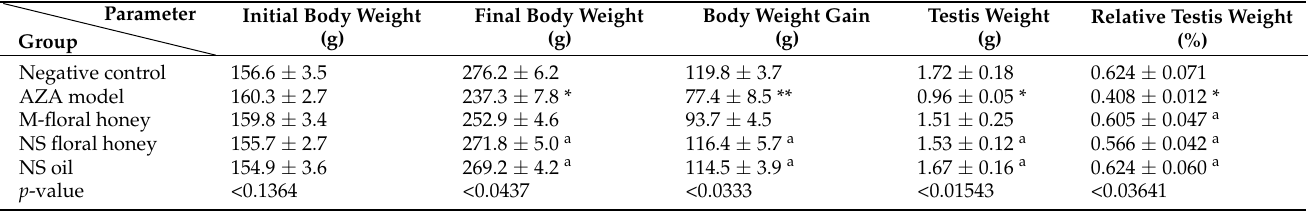
Table 1. Effects of M-floral honey, NS floral honey, and NS oil on body gain and testis